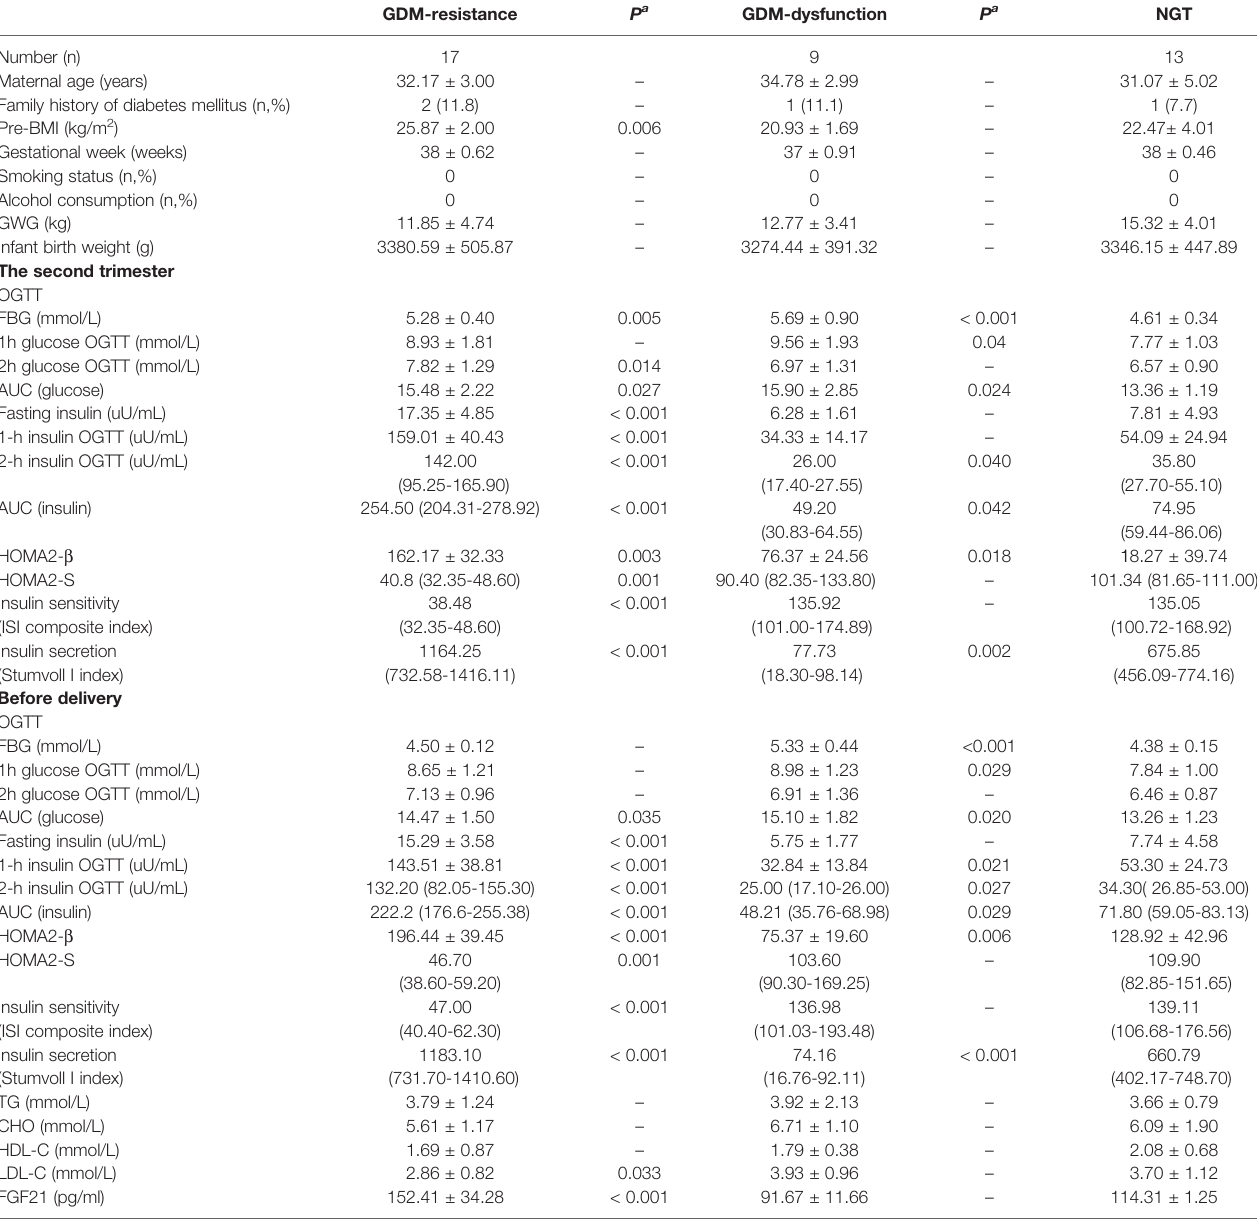
TABLE 1 | Clinical characteristics of women in the second and third